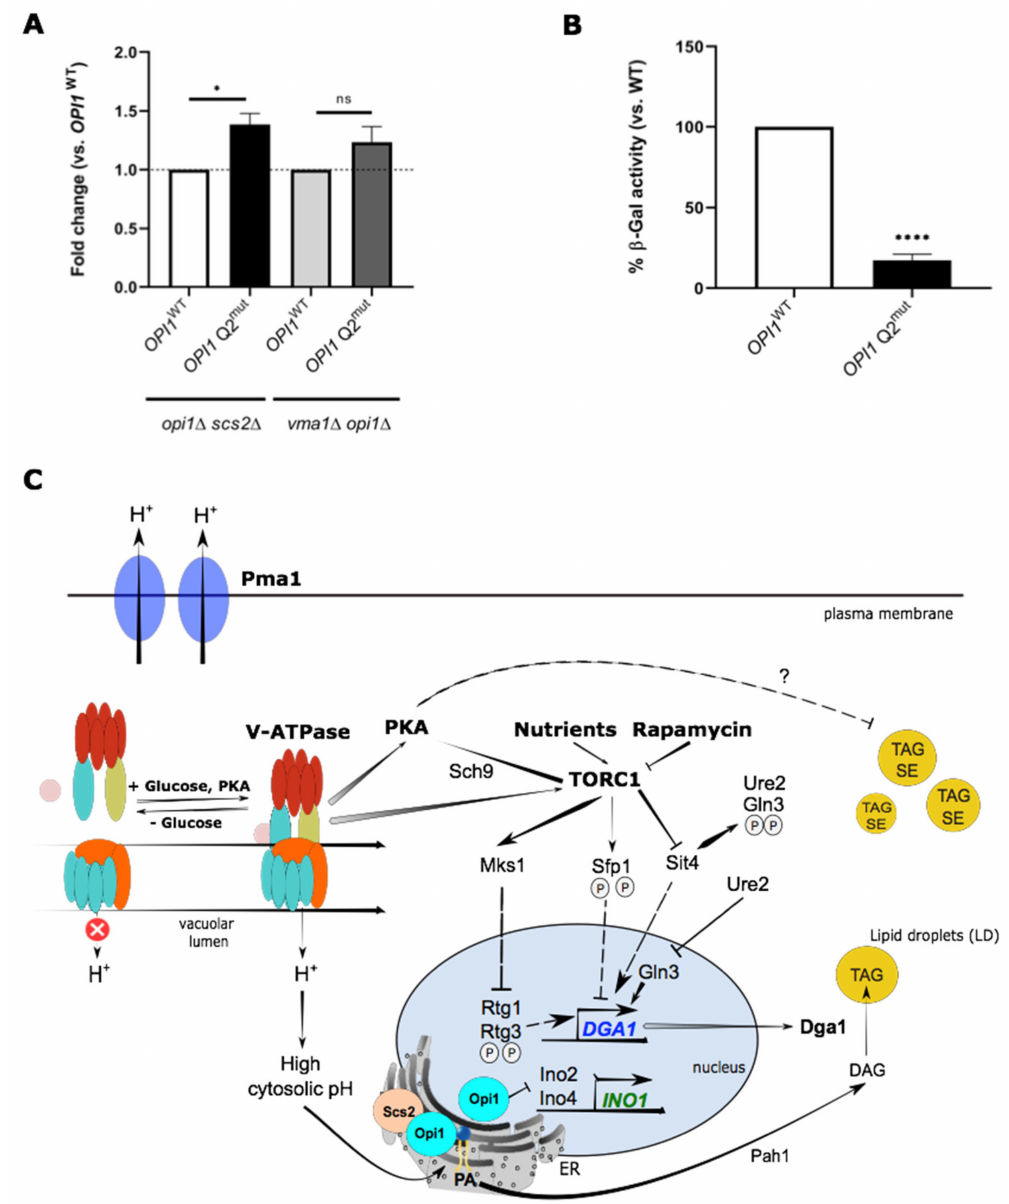
Figure 6. The decreasing affinity of Opi1 to PA is sufficient to stimulate LD generation associated with Opi1-mediated repression of the INO1 promoter. ( A ) Expression of a mutant in the Opi1 Q2 domain (Q2 mut ), which decreases